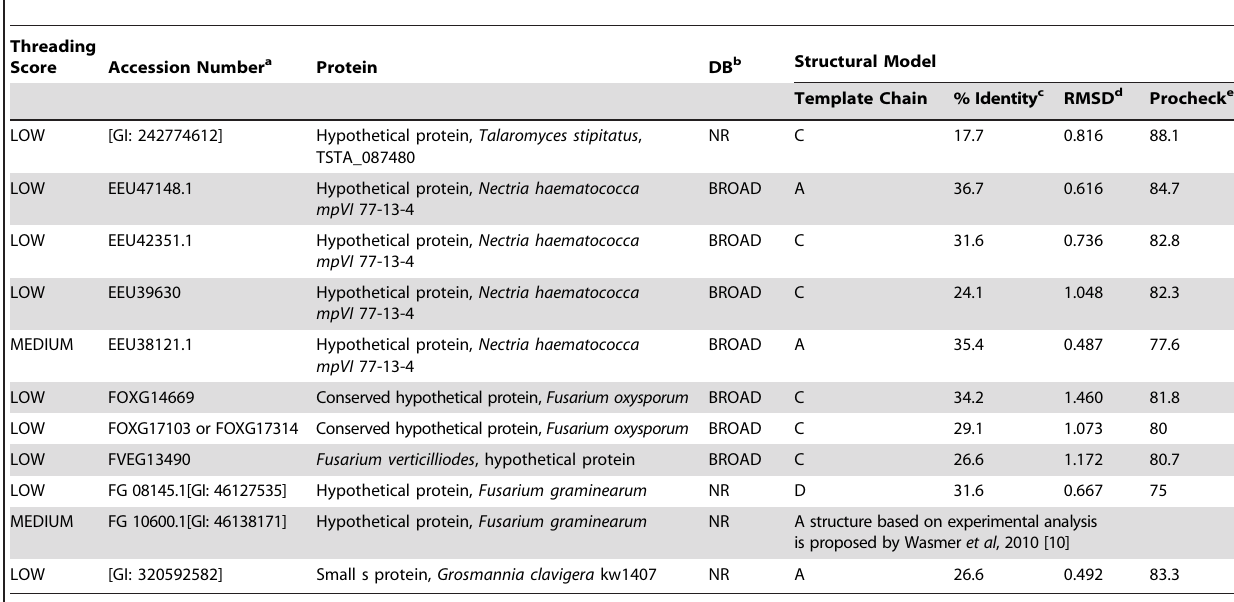
Table 1. HET-s homologs showing significant structural homology to the 2RNM solenoid.